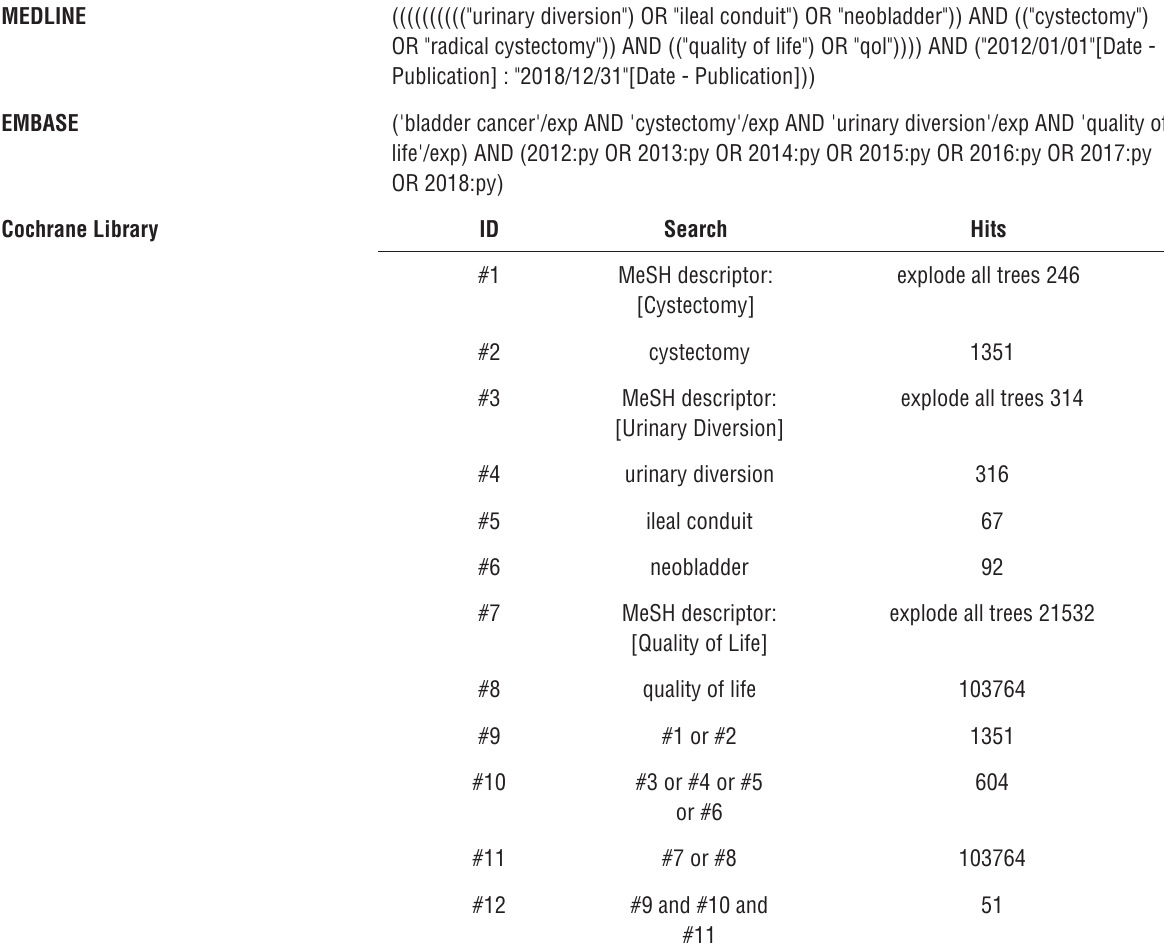
Table 1 - Database search strategy. MEDLINE (((((((((("urinary diversion") OR "ileal conduit") OR "neobladder")) AND (("cystectomy") OR "radical cystectomy")) AND (("quality of life") OR "qol")))) AND ("2012/01/01"[Date - Publication] : "2018/12/31"[Date -